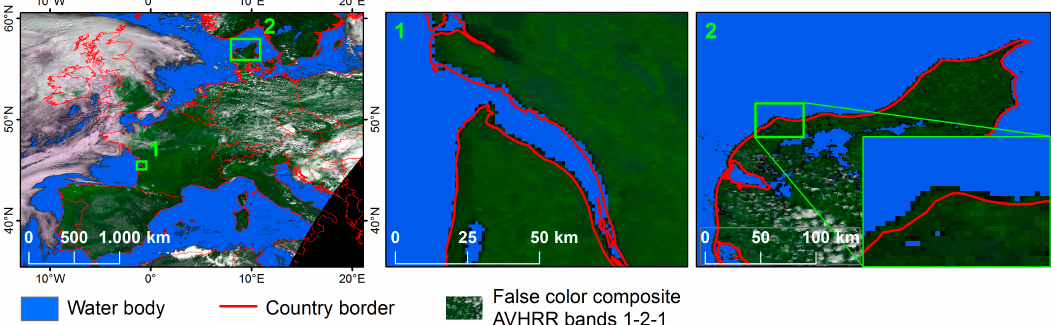
Figure 9. Influence of geolocation uncertainty on the accuracy assessment. The slight shift of